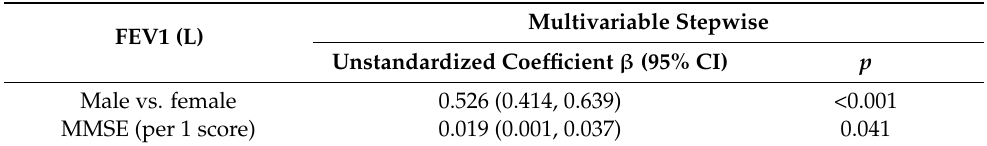
Table 3. Association of MMSE with FEV1 using multivariable stepwise linear regression analysis in participants with FEV1/FVC < 70% ( n = 231).